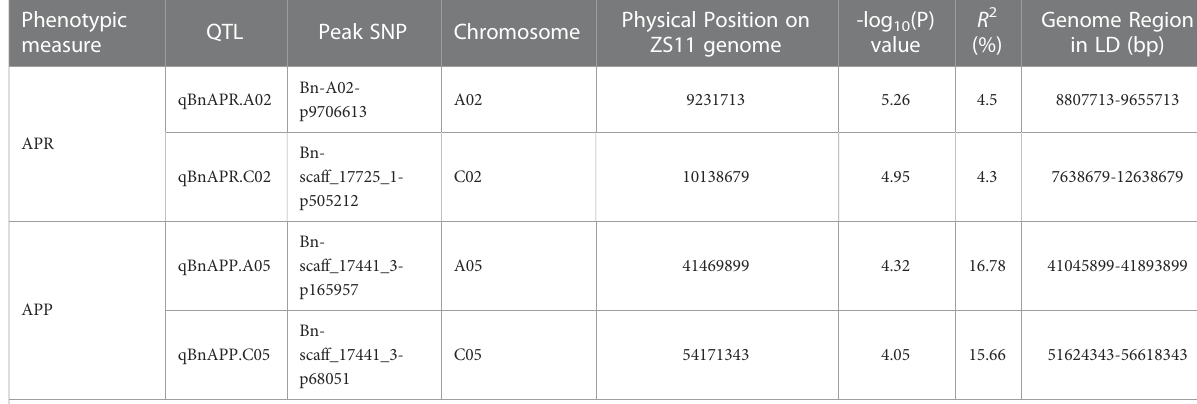
TABLE 2 QTL for pod orientation (Angle of the Pedicle to Raceme: APR and Angle of the Pod to Pedicel: APP) identi fi ed in a panel of 136 accessions of B. Phenotypic